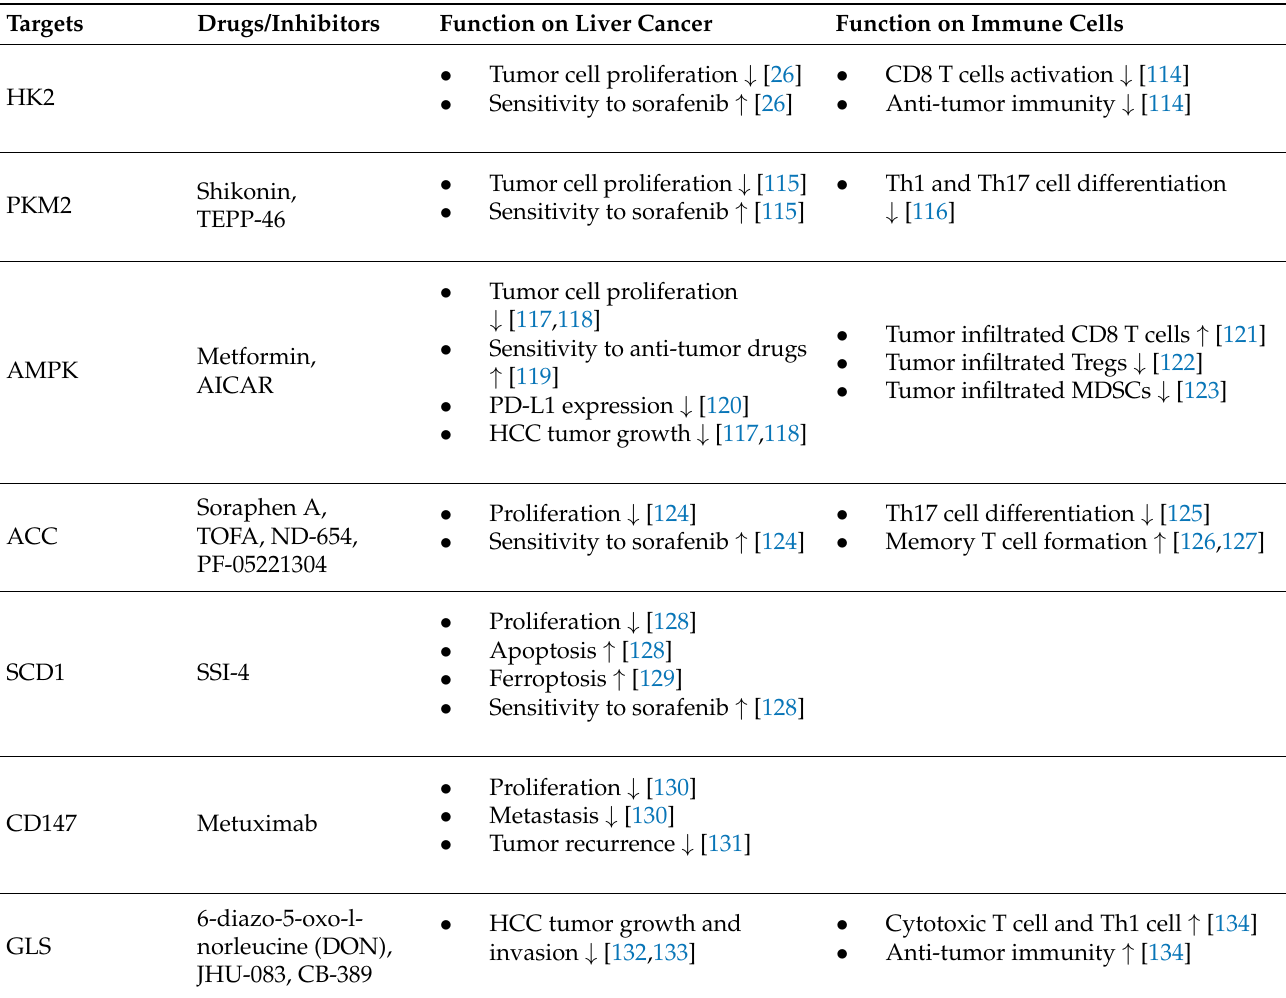
Table 2. Metabolic targets tested in vitro and/or in vivo for liver cancer and immune